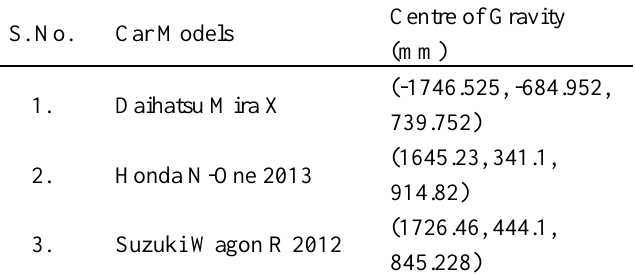
Centre of gravity of three considered vehicles S. No.